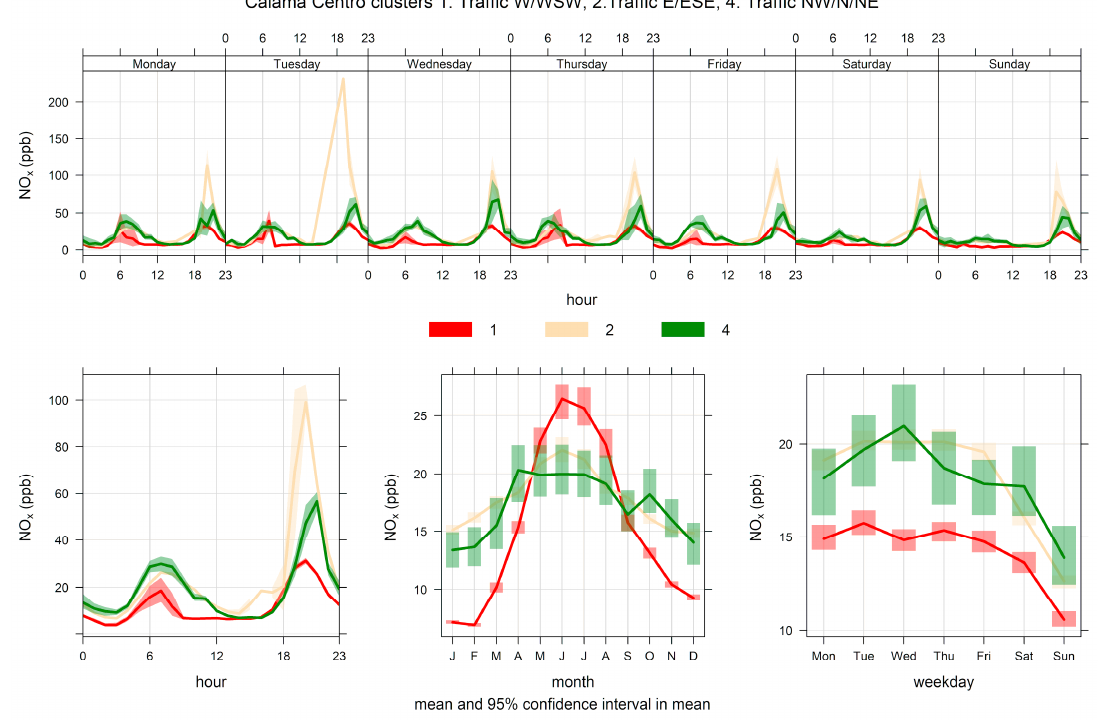
Figure 4. Time variation plot for cluster analysis source apportionment results for ambient PM 10 at Calama, 2012/10–2020/08, for a five-cluster solution. Only clusters 1, 2, and 4 are plotted for clarity’s sake.